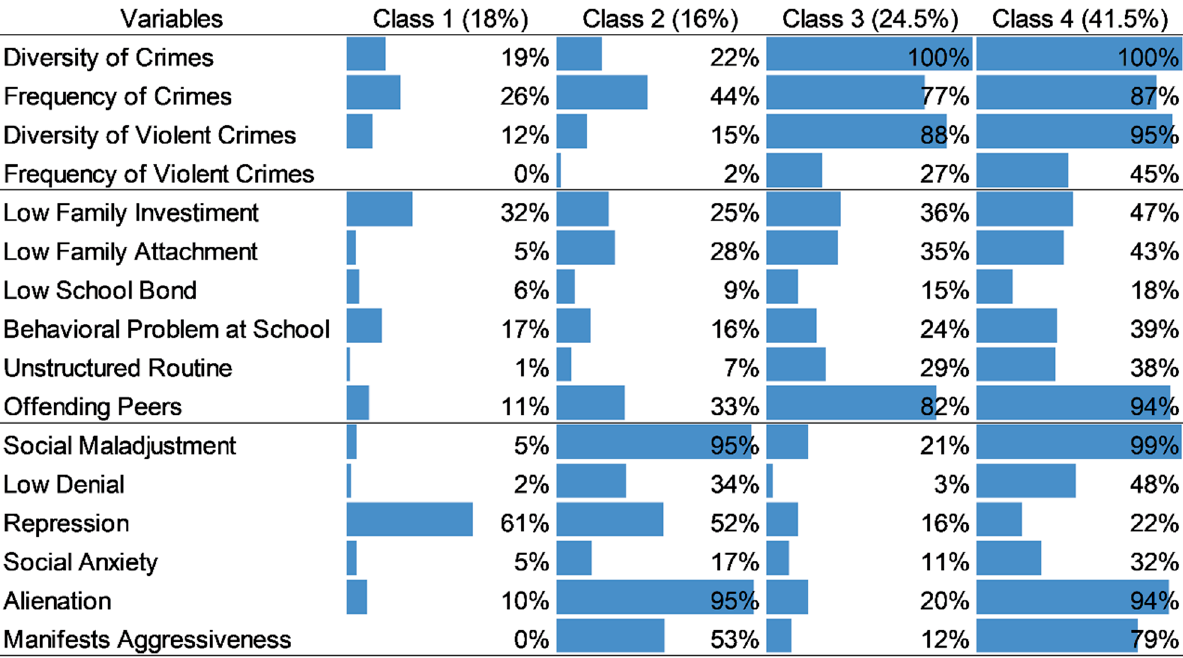
Figure 1. Percentage of adolescents from each class who obtained an “above the standard” score in the model variables.